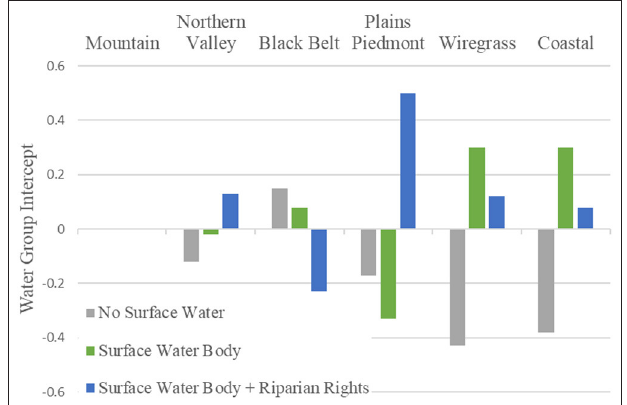
FIGURE 3 | Estimated intercepts for each surface water access group by region. Positive/Negative intercepts are interpreted as favoring/discouraging irrigation adoption all else equal.